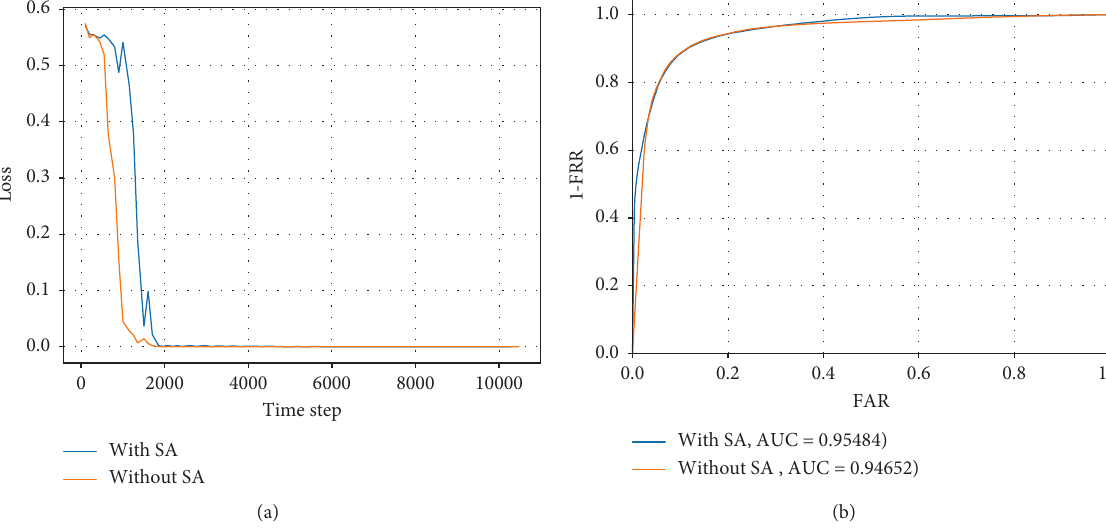
Figure 10: Network loss and ROC curve with or without spatial attention module: (a) training loss as time step went by; (b) ROC